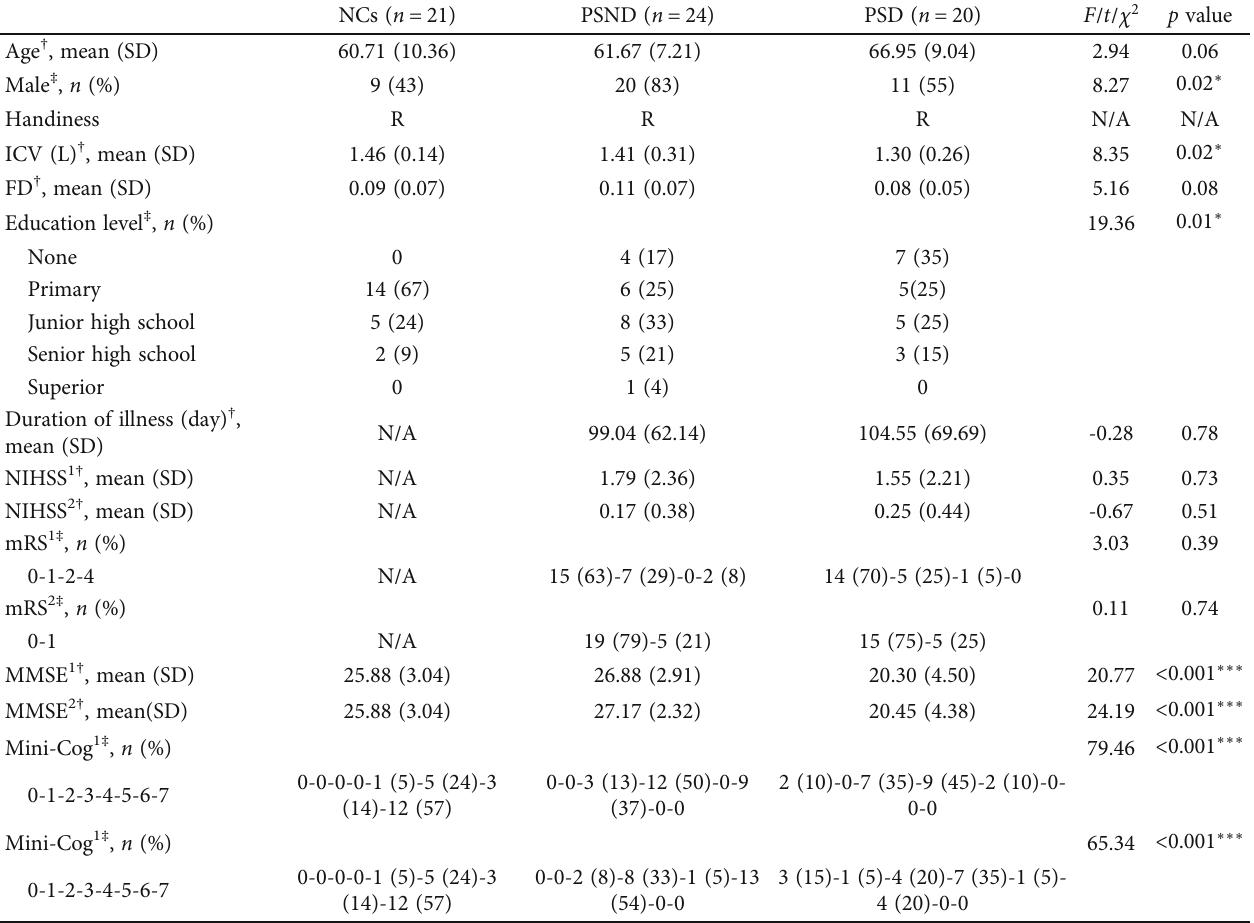
Table 1: Demographic and clinical information of all